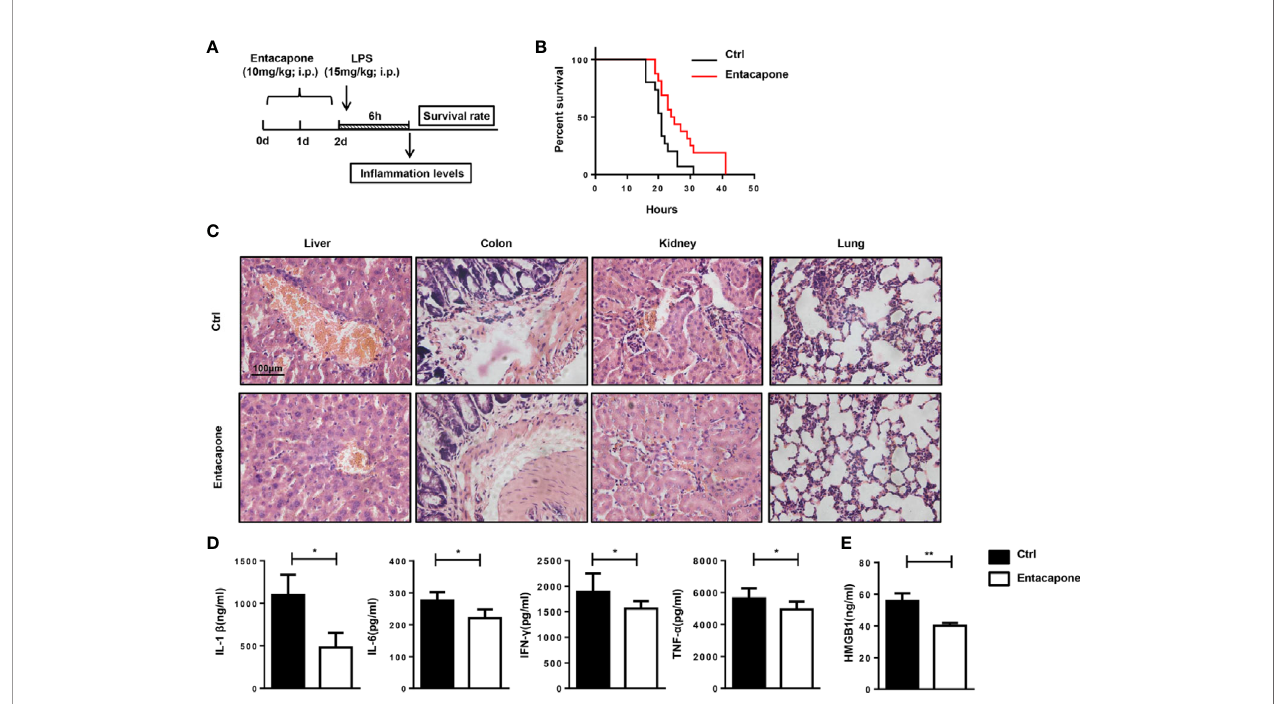
FIGURE 6 | Entacapone targeting of FTO demethylase protects against LPS-induced septic shock in vivo . C57BL/6 mice were pre-treated with or without entacapone (10 mg/kg) 2 days prior to LPS injection and 1 h before LPS treatment (15 mg/kg). (A, B) Survival rate was monitored continuously (n = 15 in ctrl group; n = 16 in entacapone group). (C) Histology of representative tissues stained with hematoxylin and eosin for each experimental group (size bar, 50 m m; n = 4 in each group). (D) Serum levels of IL-1 b , IL-6, TNF- a , and IFN- g were measured 6 h after LPS injection with or without entacapone. Plasma cytokine concentrations were measured by ELISA (n = 4 in each group). (E) Analysis of serum HMGB1 levels by ELISA. Data are shown as mean ± SEM; *P < 0.05, **P < 0.01. (two-tailed unpaired